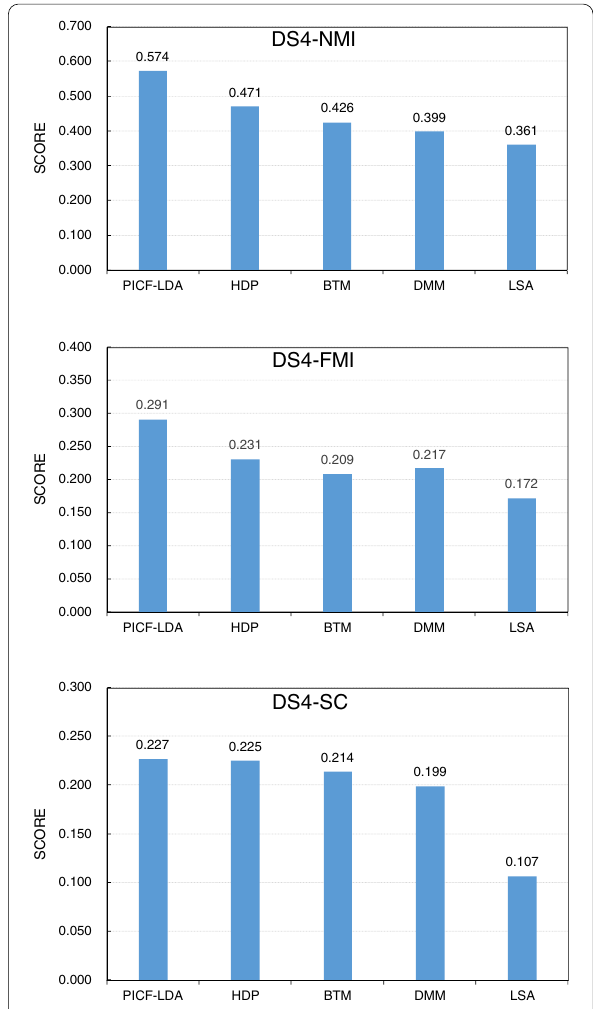
Fig. 12 Performance comparison between PICF-LDA and non-LDA models in DS4